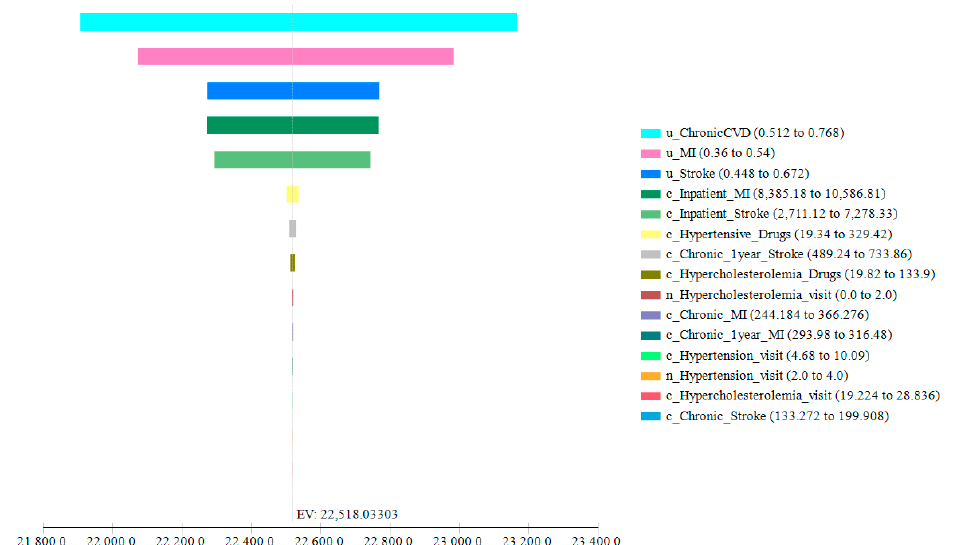
Figure 2. Tornado diagram. Bars represent the relative importance of the input parameters on the expected value (EV): the larger the bar, the higher the impact of that item. In the legend, the inputs to whom the bars correspond are in order of importance. The initial letter indicates the type of input: “u” stands for utility, “c” for cost, and “n” for number.